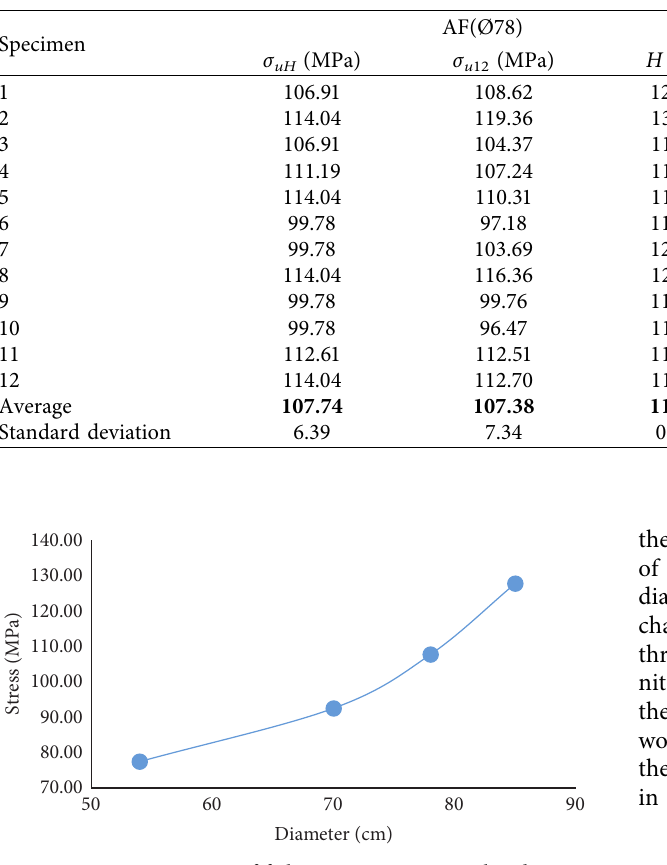
Table 2: Failure stresses in 4-point bending, diameters 78cm and 85cm.